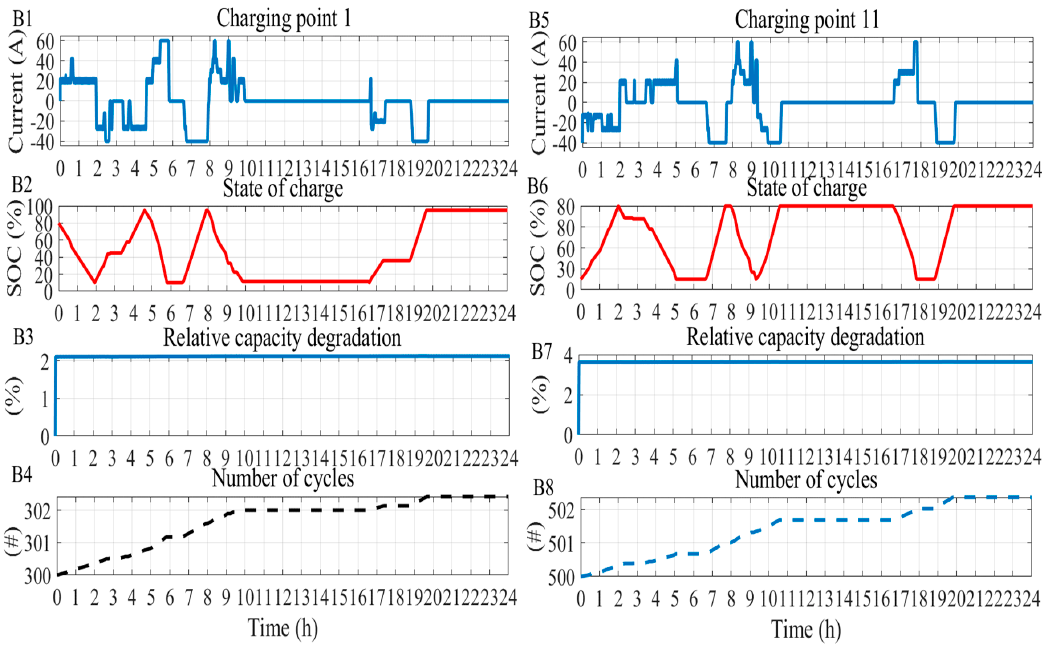
Figure 11. Comparison of the 1st and 11st EVs with different initial SoCs and cycles: ( B1 ) current profile of EV1, defined by the decentralized controller, ( B2 ) time-based SoC of EV1, ( B3 ) rate of capacity degradation of EV1, ( B4 ) number of cycles of EV1, ( B5 ) current profile of EV11, defined by the decentralized controller, ( B6 ) time-based SoC of EV11, ( B7 ) rate of capacity degradation of EV11, and ( B8 ) number of cycles of EV11.